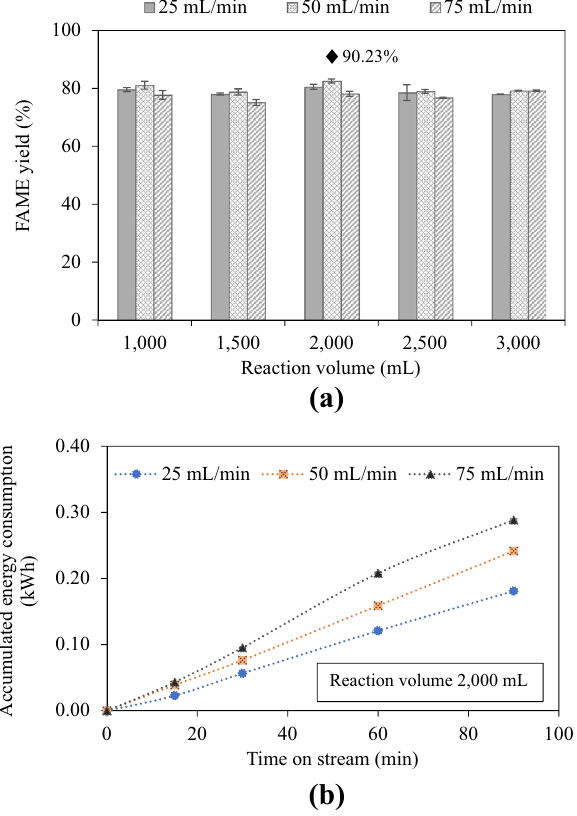
Figure 2. ( a ) Effects of reaction volume and total feed flow rate on steady-state FAME yield (refined palm oil, 1 wt% NaOH, 6:1 MeOH: oil molar ratio, 62–63 °C), ♦ = after washing and ( b ) accumulated energy consumption (2000 mL